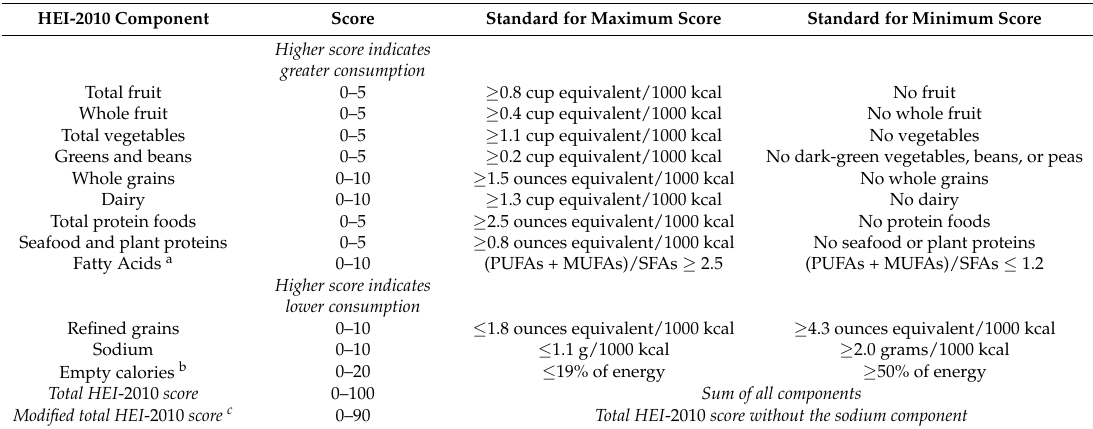
Table reproduced with minor edits from USDA’s HEI-2010 publication [17,18]. a Ratio of poly- and monounsaturated fatty acids (PUFAs and MUFAs) to saturated fatty acids (SFAs); b Empty calories include calories from discretionary solid fats and added sugars as well as from alcohol beyond moderate amount determined by 2010 US